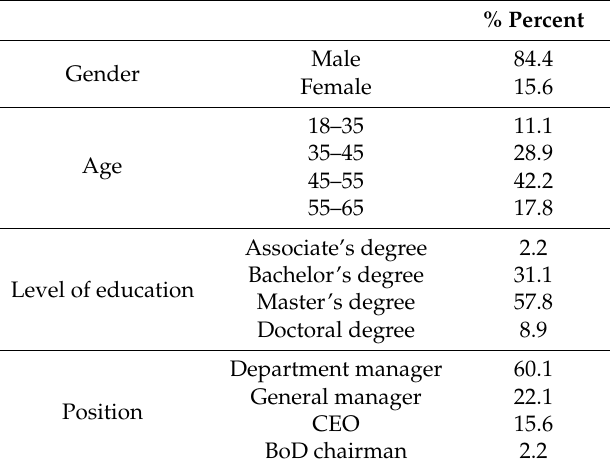
Table 4. Respondents’